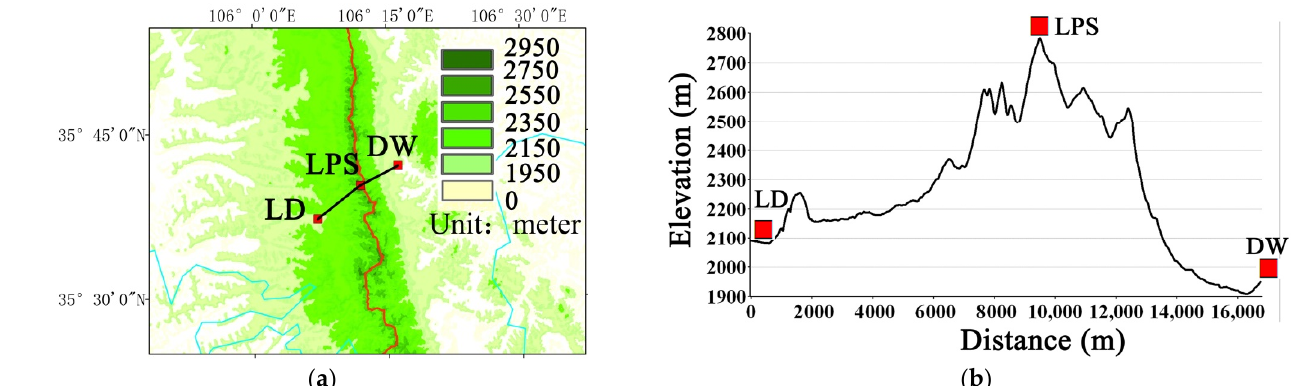
Figure 1. Topography of the Liupan Mountains and the study area (denoted by the black dashed frame).